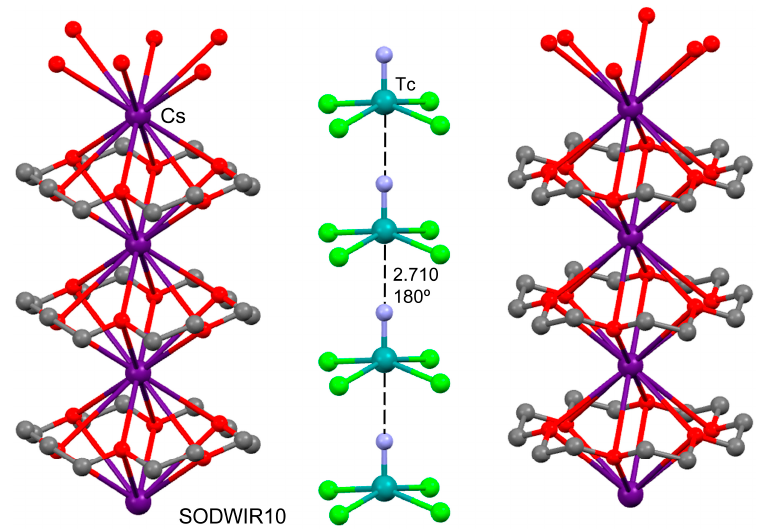
Figure 3. Ball and stick representation of the X-ray structure SODWIR10. Distance in Å. Color code: Carbon grey, Chlorine green, Nitrogen blue, Technetium teal, Cesium purple.